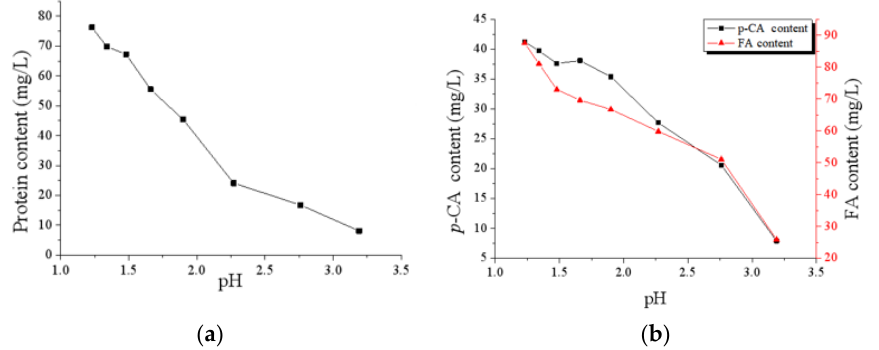
Figure 3. Evaluation of protein and phenolic acids contents of CAH during ED deacidification process (( a ): protein; ( b ): phenolic acids). Table 4. Characteristics of the examined CAH liquor.